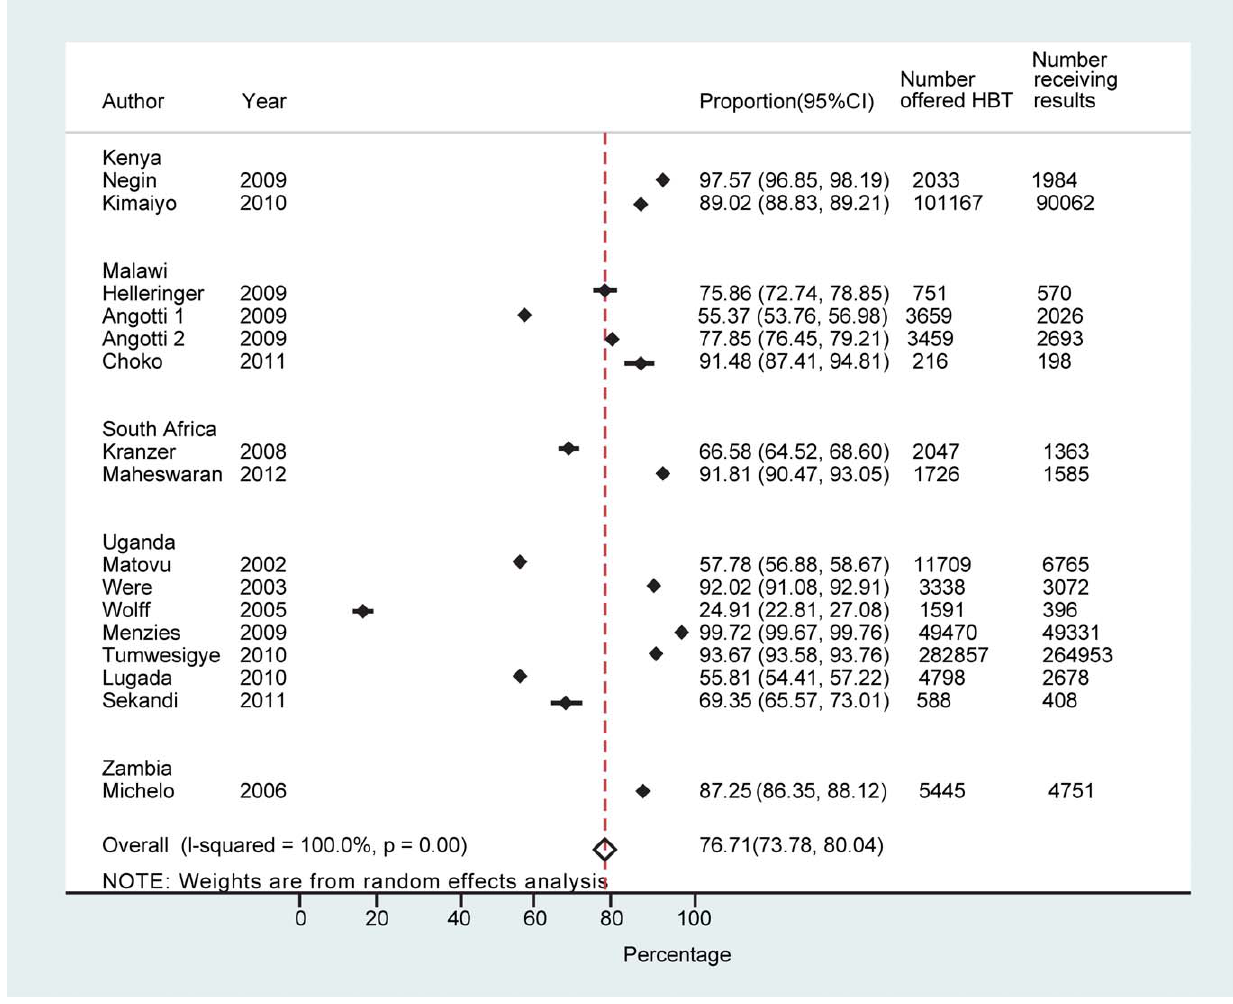
Figure 3. Proportion achieving knowledge of HIV status overall.